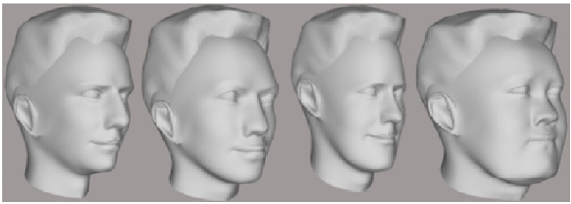
Figure 16: Examples of the deformed head models.